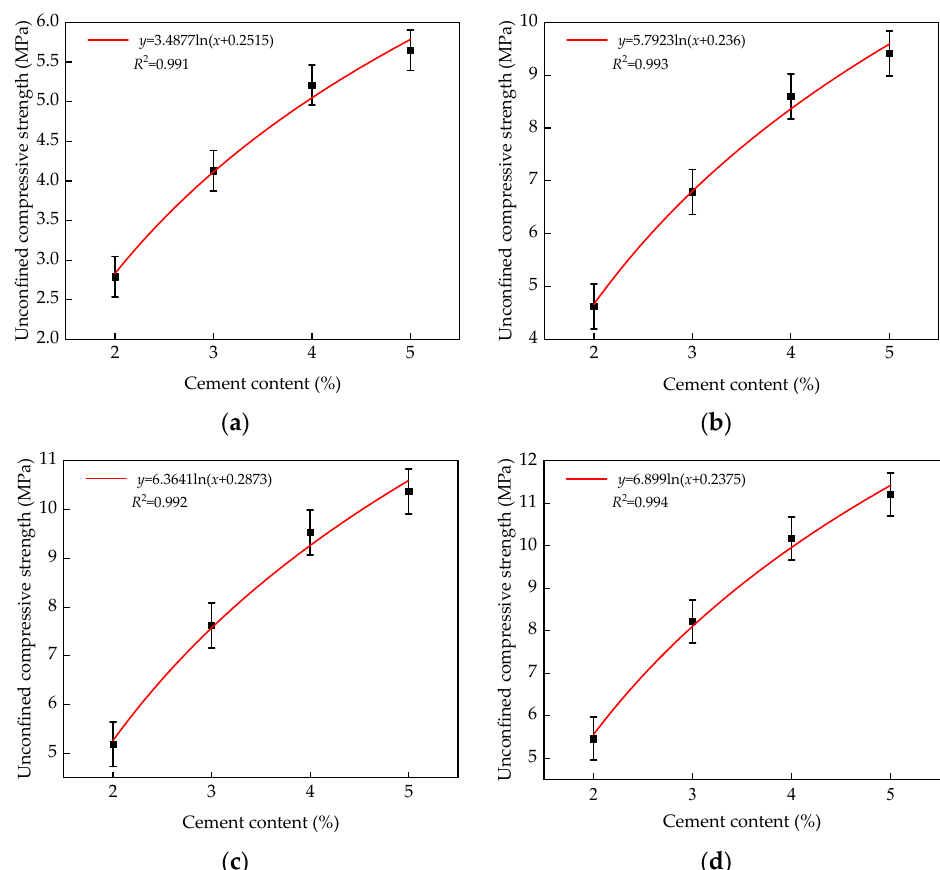
Figure 10. Fitting formula of unconfined compressive strength of different cement content at various ages: ( a ) 7 days; ( b ) 28 days; ( c ) 56 days; ( d ) 90 days.